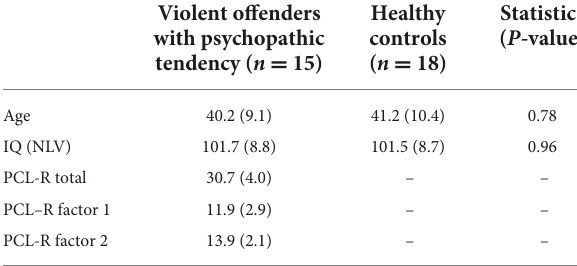
TABLE 1 Group characteristics (mean, standard deviation) of the group of violent offenders with psychopathic tendency and healthy matched control